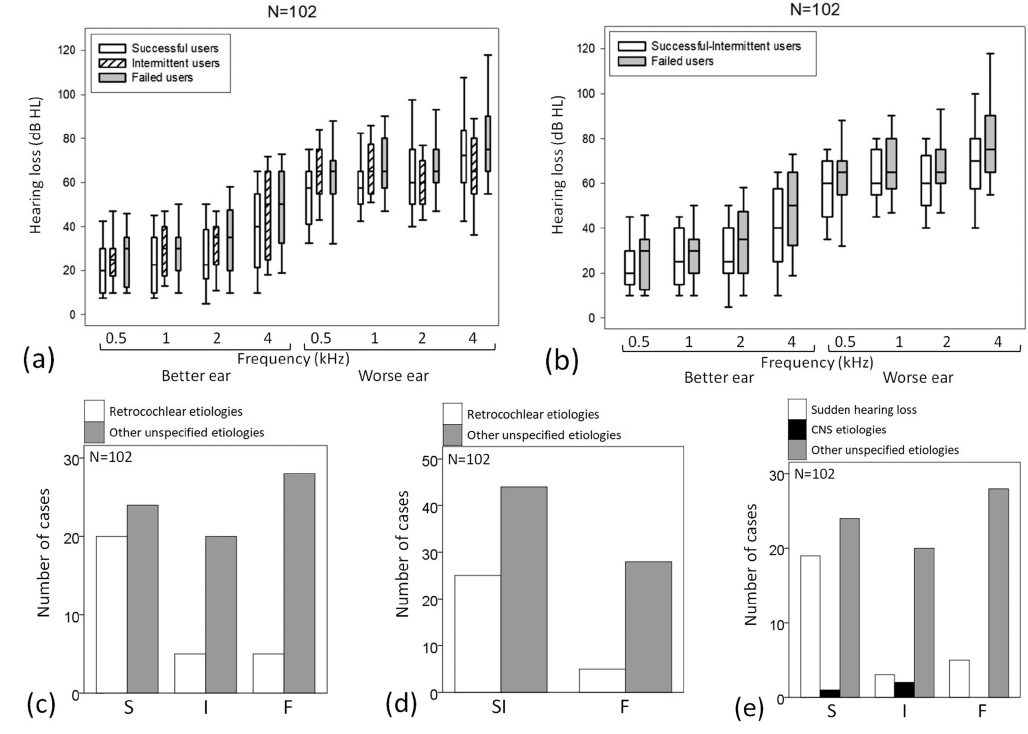
Figure 1. ( a – e ) In all cases (n = 102), box plots of differences in the hearing thresholds according to ( a ) three and ( b ) two outcomes. Comparison by the etiology of hearing loss according to ( c , e ) three and ( d ) two outcomes.